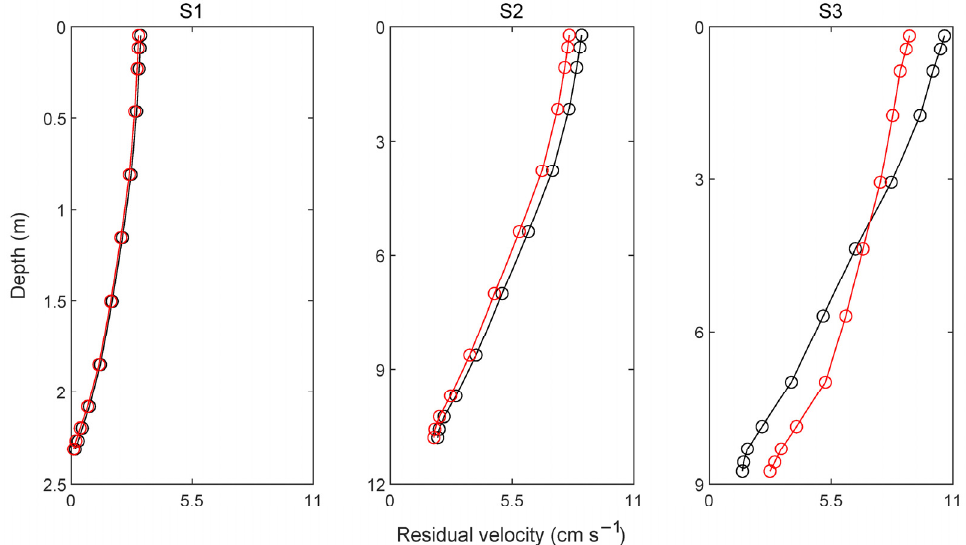
Figure 7. Vertical profiles of the magnitude of the residual circulation at S1, S2, and S3 during CS1 (spring–summer season) (red line) and CS2 (autumn–winter season) (black line).